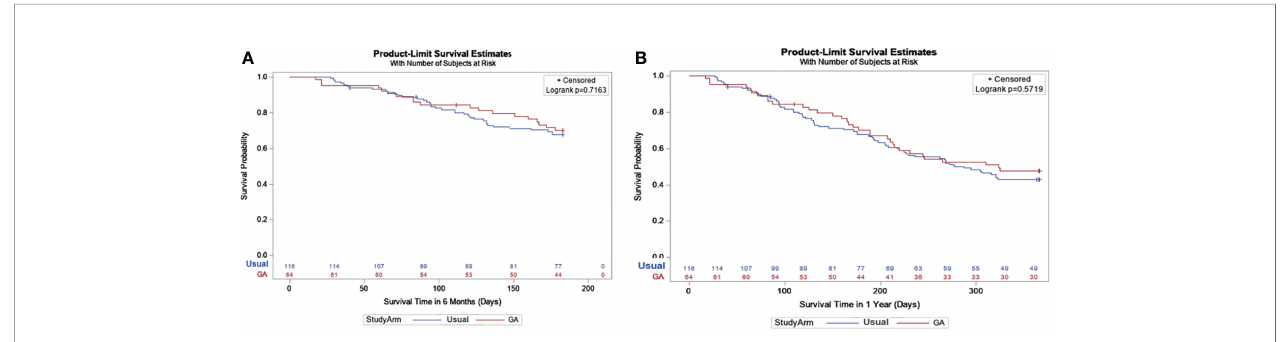
FIGURE 3 | (A) Survival at 6 months based on Kaplan-Meier Estimates and Cox Model*. *Geriatric Assessment Intervention: 70.1% vs. Usual Care: 67.7%; Adjusted Hazard Ratio: 0.90 95% CI: (0.52-1.57), P = 0.72. (B) Survival at 1 year based on Kaplan-Meier Estimates and Cox Model*. *Geriatric Assessment Intervention: 47.8% vs. Usual Care: 43.1%; Adjusted Hazard Ratio: 0.89 95% CI: (0.58-1.36), P =